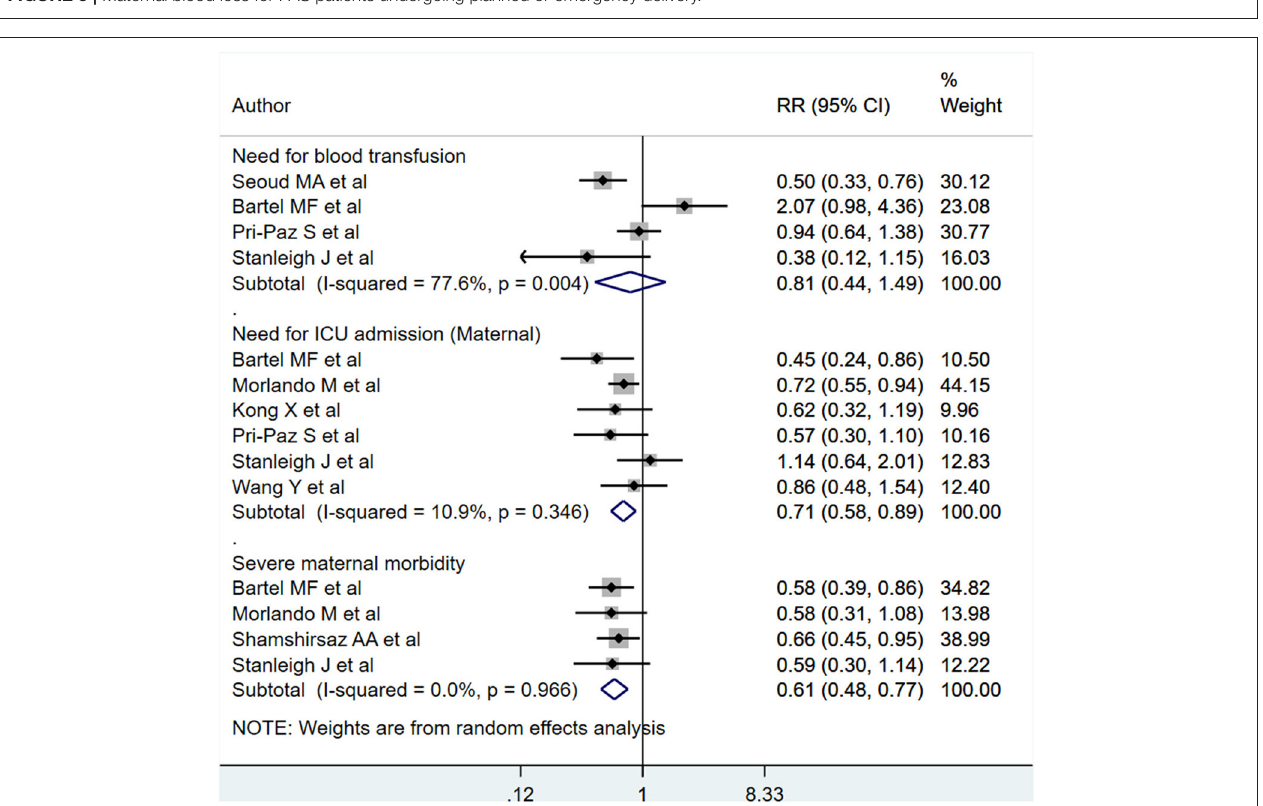
FIGURE 4 | Maternal blood transfusion incidence, ICU admission, and severe morbidity for PAS patients undergoing planned or emergency delivery.